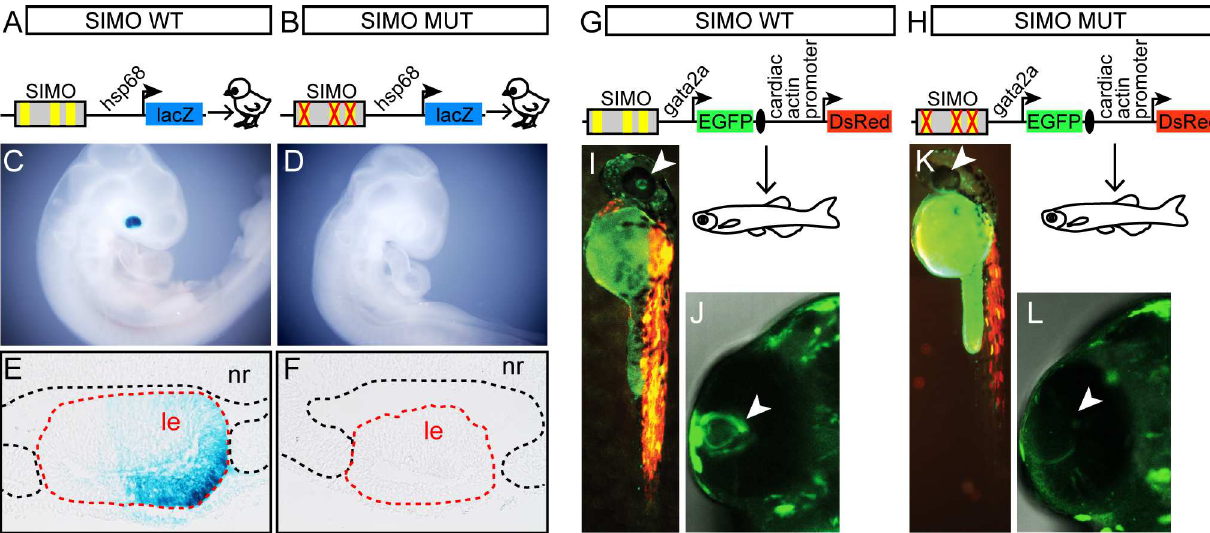
Fig 4. Characterization of SIMO wild-type and mutant enhancer by reporter gene assaysin chick and zebrafish. ( A , B ) Schematic view of reporter constructs used for in ovo electroporation of chick embryos. Reporterconstructs carry wild-typeor mutant mouse SIMO element upstream of hsp68 minimalpromoterand β -galactosidase open readingframe. In mutant SIMO Meis bindingsites were abolished by introductionof specific single-pointmutations changing Meis recognitionsequenceTGACAG/A into TcACAG/A. ( C–F ) Whole-mount view or histological sections through the eye of β -galactosidase–stained chick embryos of stage HH21-22electroporated either with ( C, E ) wild-typeor with ( D, F ) mutant SIMO fragment. Positive X-gal staining correlateswith the activity of reporter constructs. Wild-type SIMO fragment supports reporter construct expressionin lens but not the mutant SIMO fragment. ( G, H ) Schematic view of reporter constructs used for transgenesis in zebrafish. Reporter constructs carry wild-typeor mutant zebrafishSIMO elementupstream of zebrafish gata2a minimalpromoter and EGFP open readingframe. In mutant zebrafish SIMO Meis binding sites were abolishedby introductionof specific single-pointmutations changing Meis recognitionsequenceTGACAG/A into TcACAG/A. In order to control for transgenesis efficiency in vivo the reporter genescontain a second cassette composed of a cardiac actin promoter driving the expressionof a red fluorescent protein (DsRed). EGFP and DsRed transcriptional units are separatedby an insulator. ( I-L ) Wild-type SIMO enhancer activity is detected at 48 hpf (n = 160, 68% EGFP of DsRed positive), (I, J) , but not for the mutant construct (n = 36, 89% EGFP negativeof DsRed positive) ( K, L ). LE—lens, NR—neural retina.